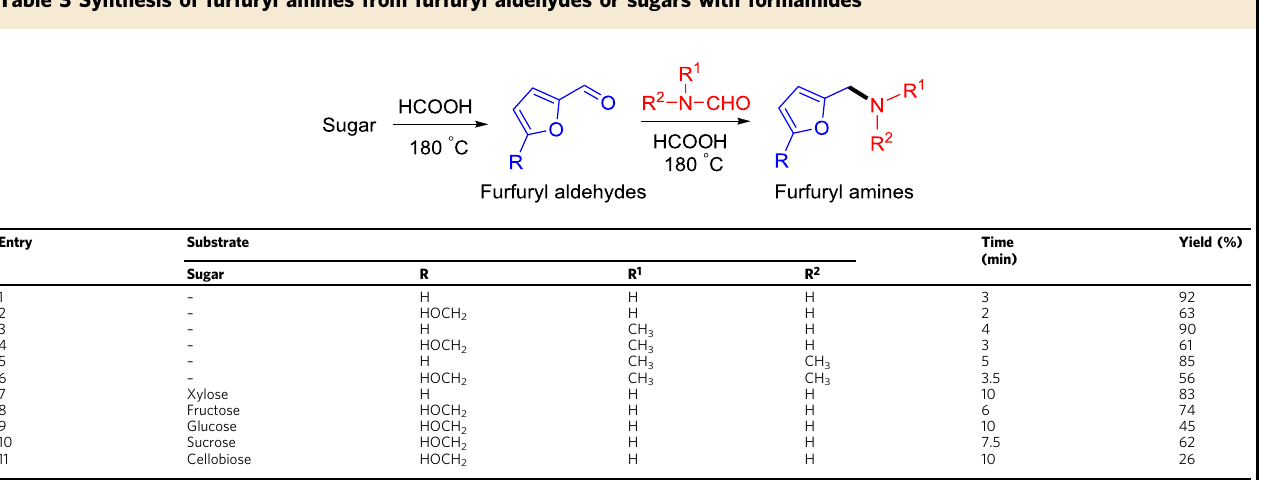
Table 3 Synthesis of furfuryl amines from furfuryl aldehydes or sugars with formamides